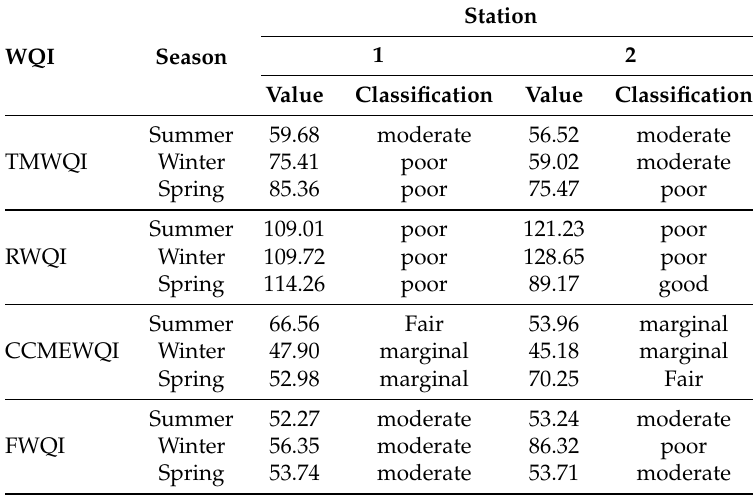
Table 8. WQI values and